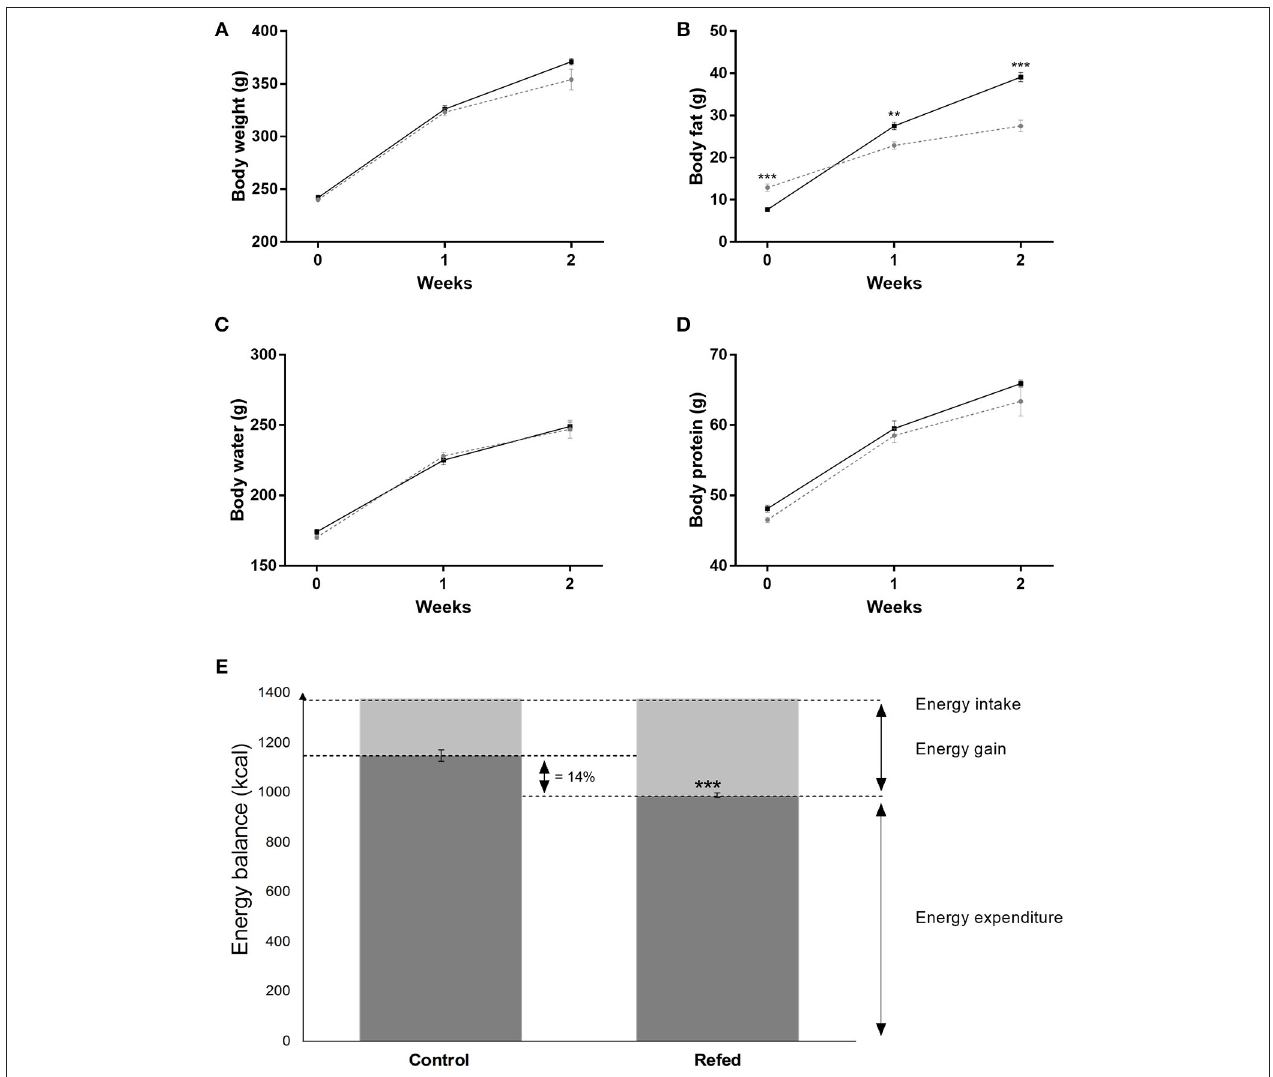
FIGURE 1 | Body weight (A) , body water (B) , body fat (C), and body protein (D) at the end of semistarvation (day 0 of refeeding) and at week 1 and week 2 of refeeding; the refed are shown in black lines and the control animals in gray (broken) lines. The bar charts (E) show the data on energy balance (energy intake,